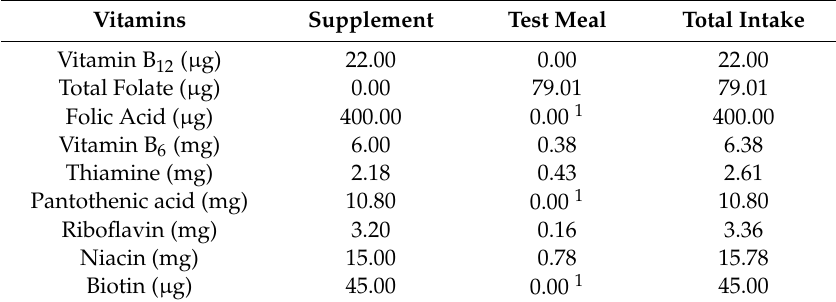
Table 2. Estimated B-vitamin intake from a single multivitamin tablet and the standard breakfast test meal by the study